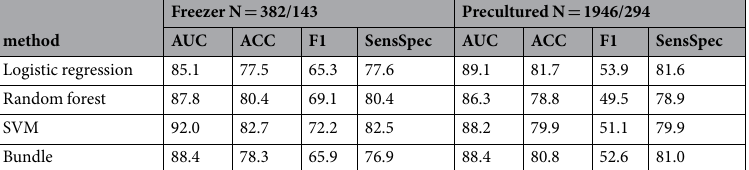
Table 1. Cross-validation results for the different classifier candidates. The results are displayed separately for the two culturing methods that are relevant to the task. The metrics are AUC = area under the ROC curve, ACC = Accuracy, F1 = the harmonic mean of precision and recall, and SensSpec = the sensitivity and specificity of the classifier. Images of cells cultured as cell lines do not contain any fibroblasts and are classified perfectly by each of the tested classifiers. The best variation of each method was chosen based on the area under the AUC. Reference class for the metrics is